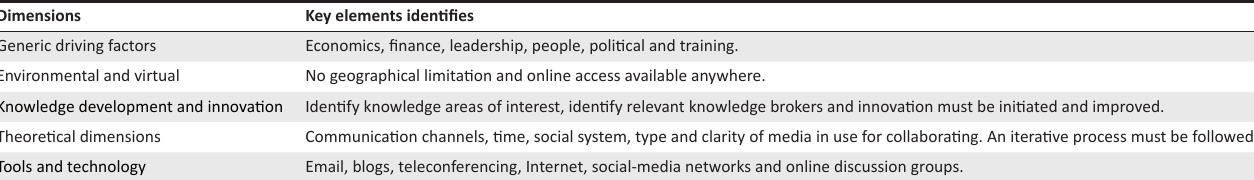
TABLE 4: Matrix of e-collaboration